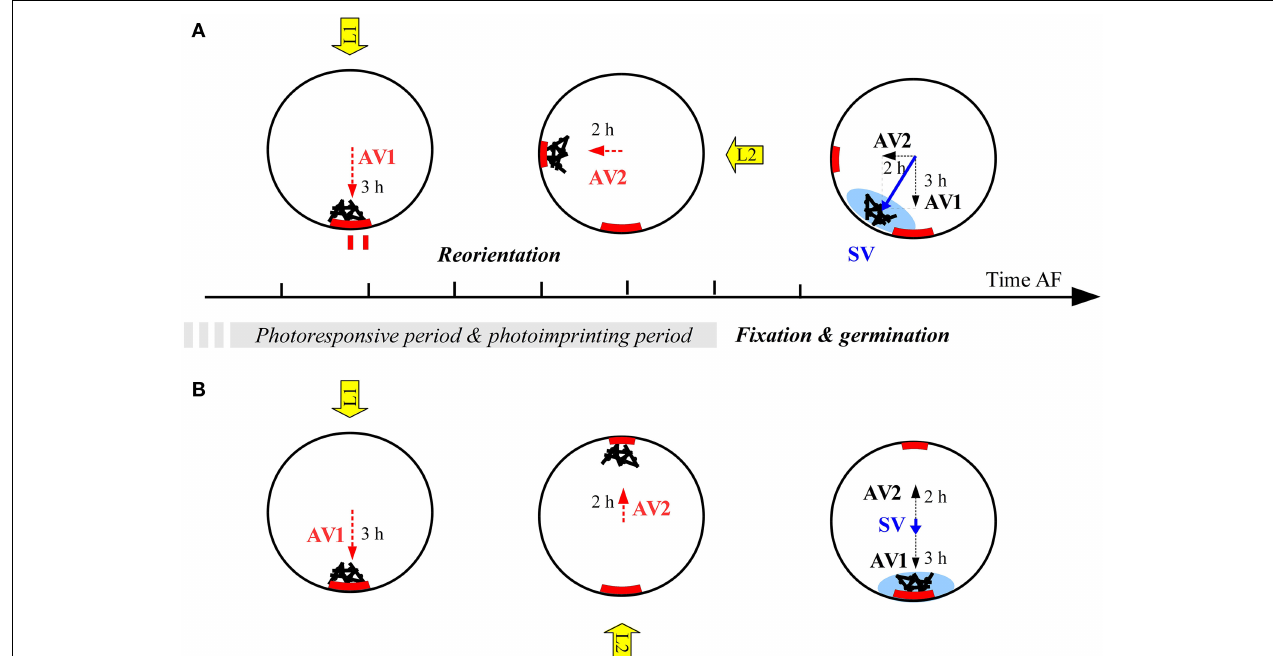
FIGURE 7 | Proposed scenario for integration of polarization vectors as vectorial sum under after reorientation of 90 ◦ (A) or 180 ◦ (B). AV, axis amplification vector; SV, axis stabilization vector. Red block arcs depict the hypothesized intrinsic factor responsible for the imprinting of unknown nature. Blue shading denotes F2